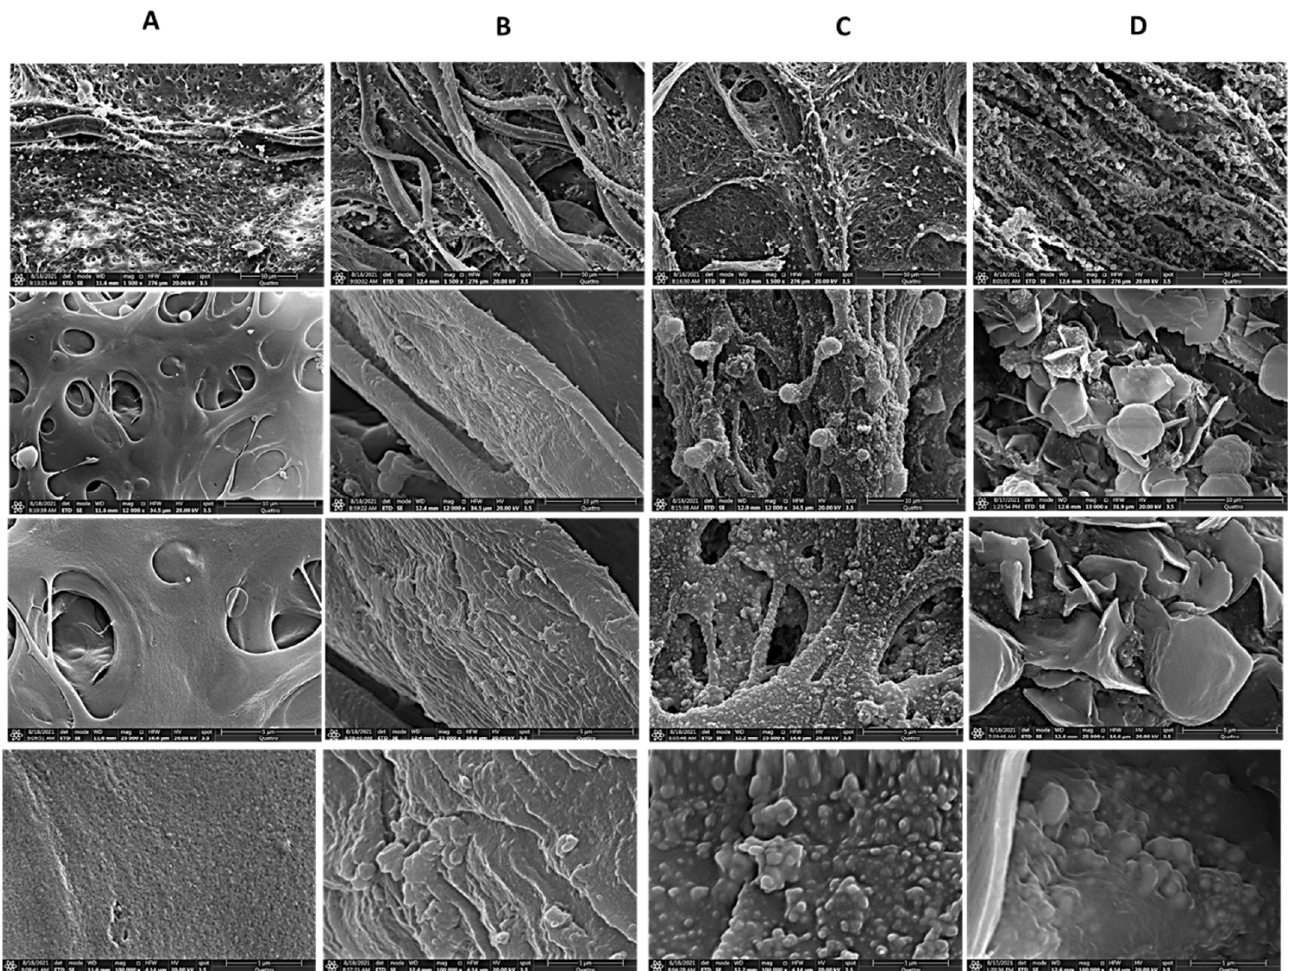
Figure 2. SEM images of ( A ) Cell-F, ( B ) DA-Cell-F, ( C ) C8s-Ag-DA-Cell-F, and ( D ) C18s-Ag-DA-Cell-F at a different magnification of 1500 × , 12,000 × , 25,000 × and 100,000 ×